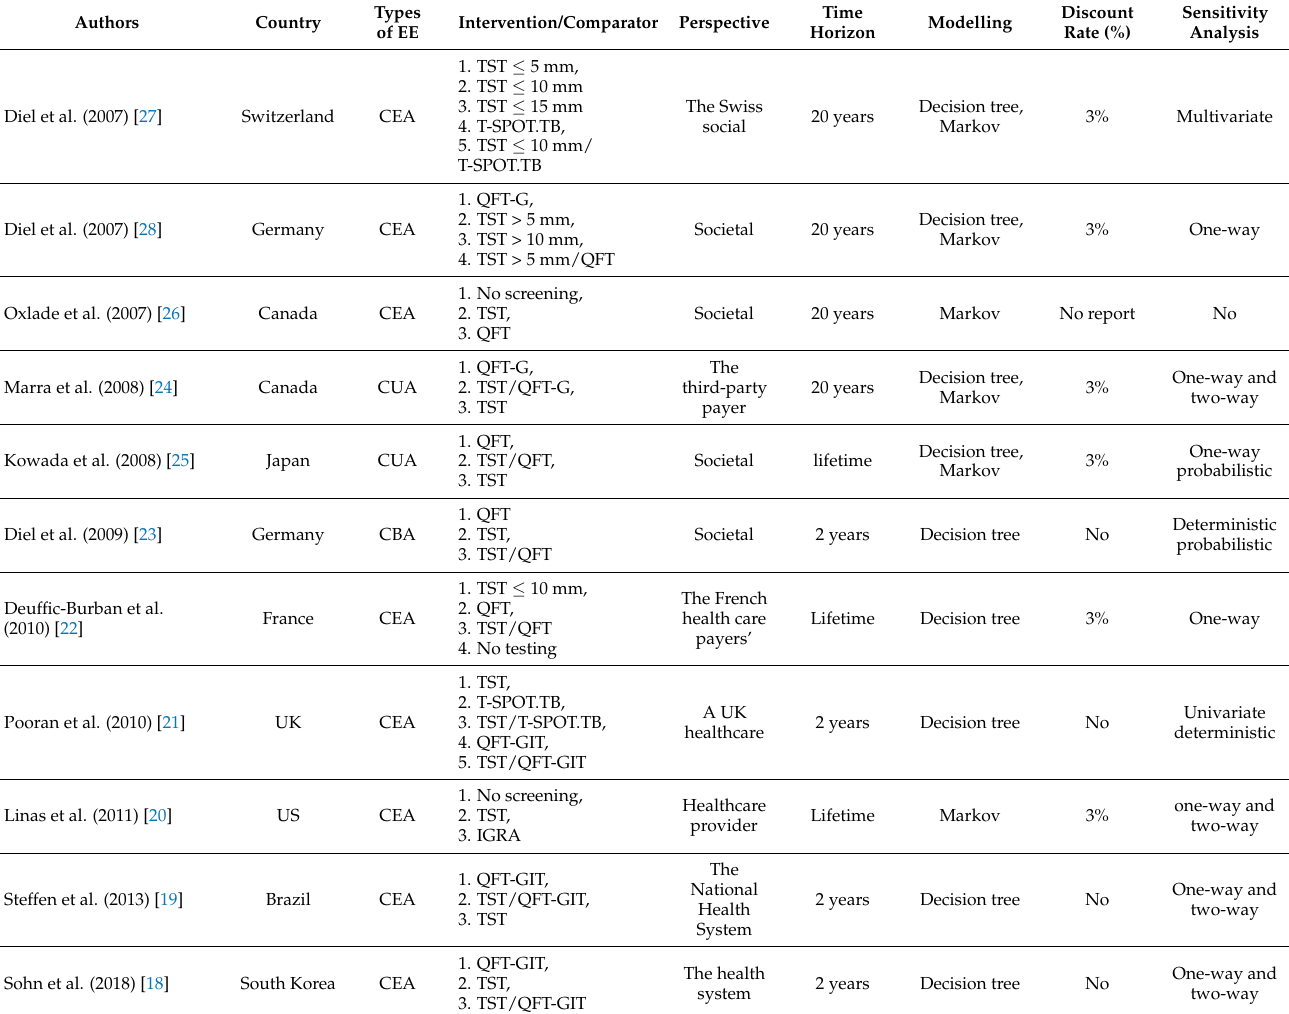
Table 1. The characteristics of economic evaluation